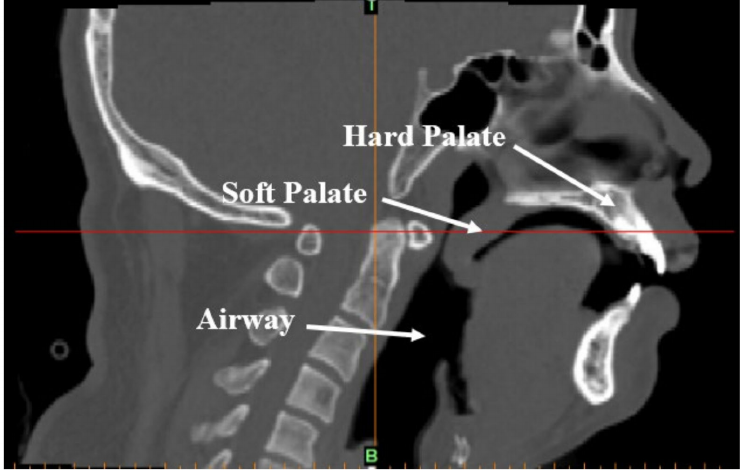
Figure 2. CT-scanned image of the upper airway of an OSAHS patient in a supine position and sleeping